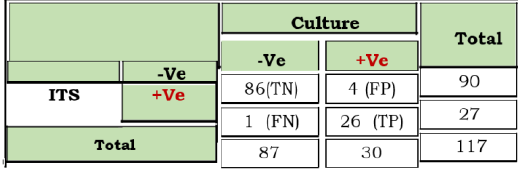
Table 4 Positive and negative results of culture compared to